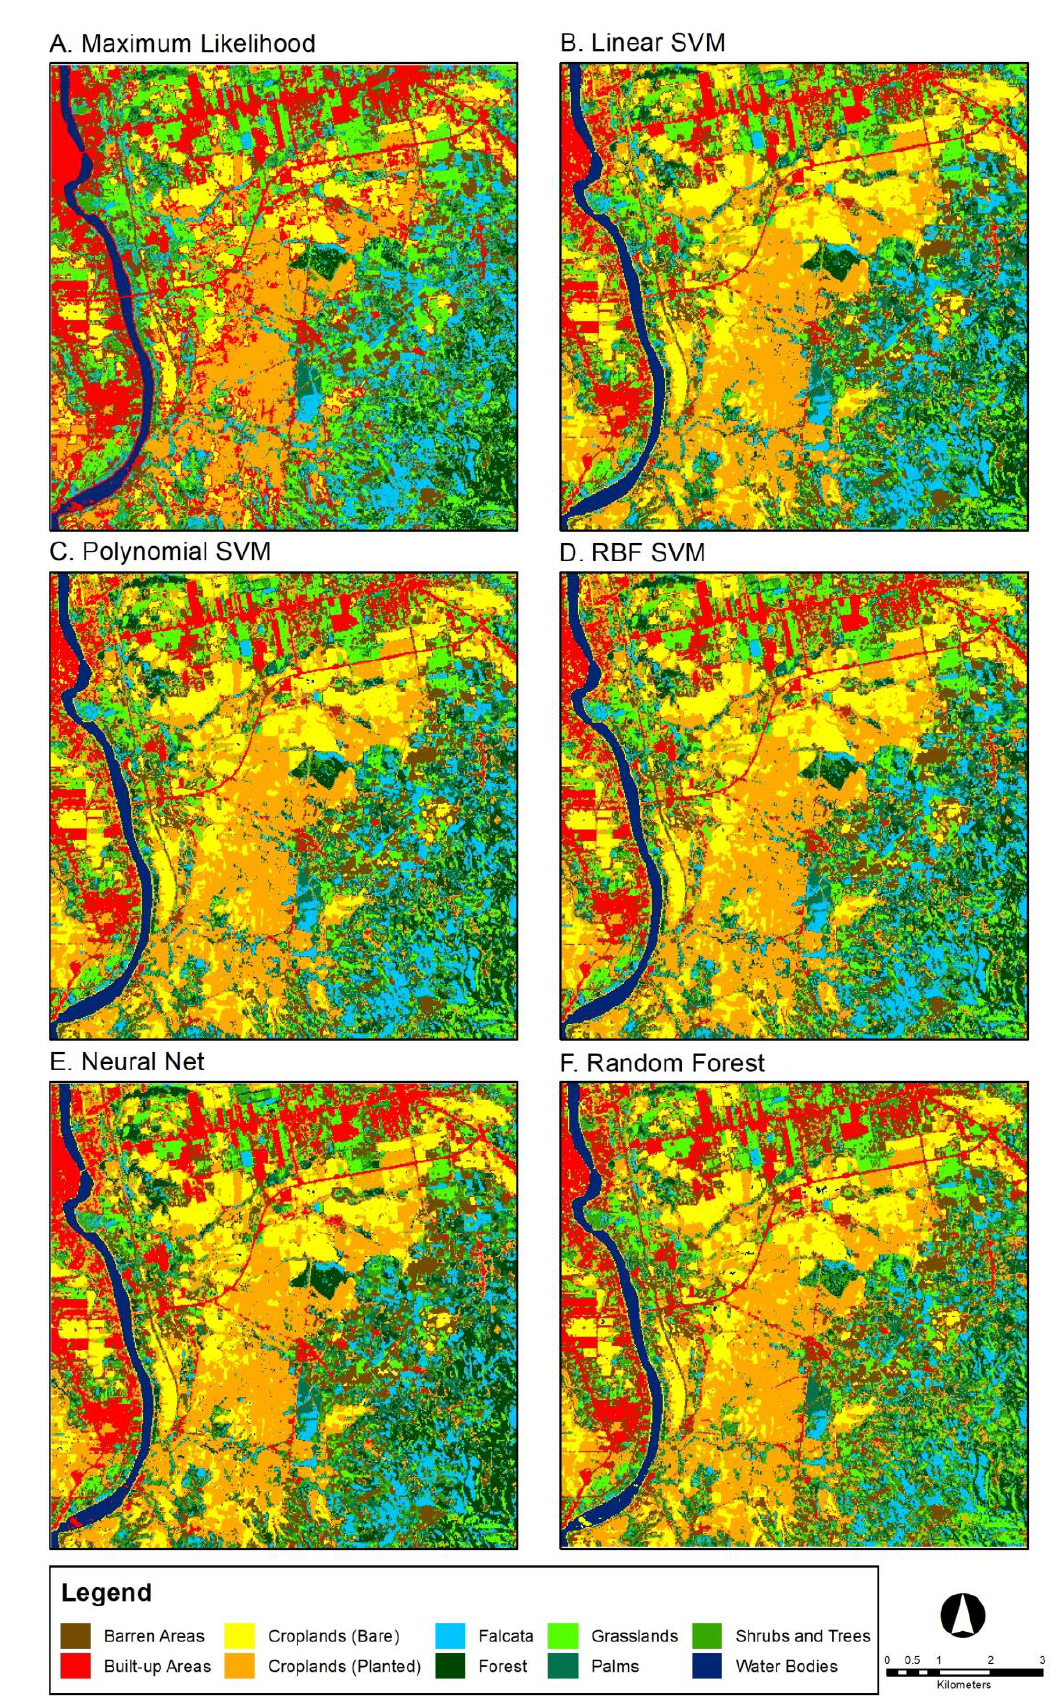
Figure 3. Sentinel-2 20-m resolution classification